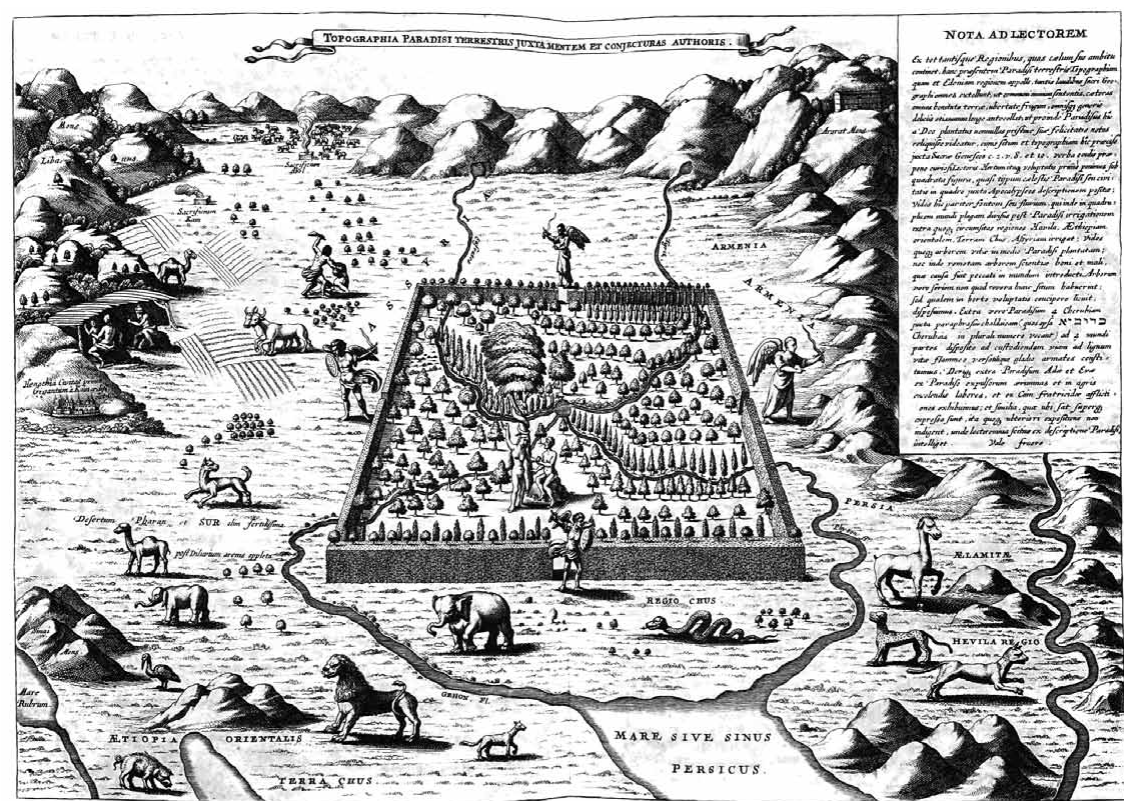
fig. 5. Terrestrial Paradise. Source : Kircher, a. 1675. Arca Noë. amsterdam: j. janssonium a